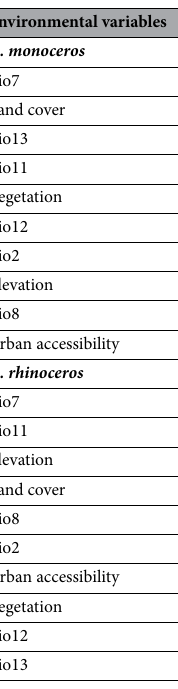
Table 5. Environmental variables considered in Oryctes monoceros and O. rhinoceros niche models and mean percentage contribution of environmental variables in the models; values were averaged over ten repeated